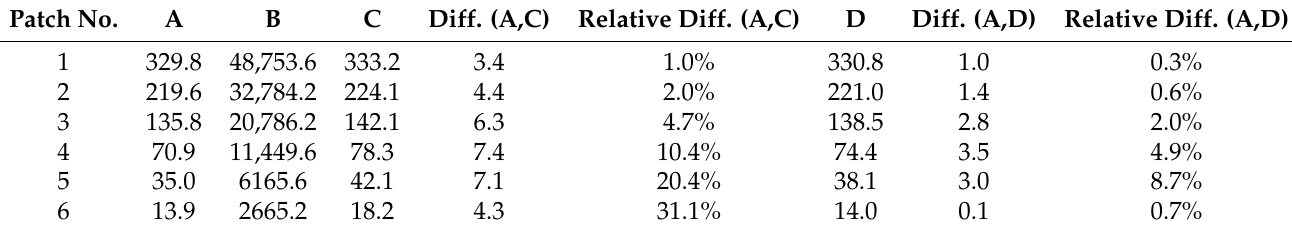
Table 5. The laser scanner luminance measurements compared to a spectroradiometer. The table shows the differences and relative differences between the reference luminance measured with a spectroradiometer and the luminance measured with a TLS. The luminance measured with a TLS was calculated by linear regression and by linear regression and noise removal. Patch